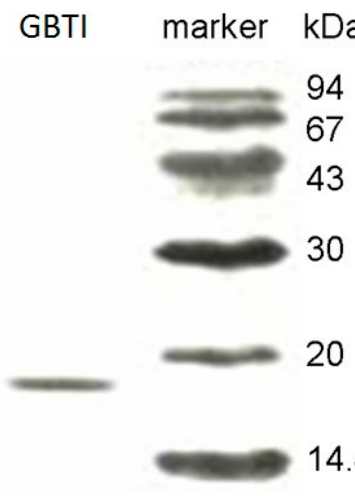
Figure 1. SDS-PAGE results of gold bean trypsin inhibitor (GBTI, which was fraction SU2, 12 μ g) and molecular mass marker proteins from GE Healthcare. Molecular mass of trypsin inhibitor was 17.5 kDa. The marker proteins included phosphorylase b (94 kDa), bovine serum albumin (67 kDa), ovalbumin (43 kDa), carbonic anhydrase (30 kDa), soybean trypsin inhibitor (20 kDa), and α -lactalbumin (14.4 kDa). Table 1. Yields and trypsin inhibitory activities of various chromatographic fractions (from 260 g dry gold beans).